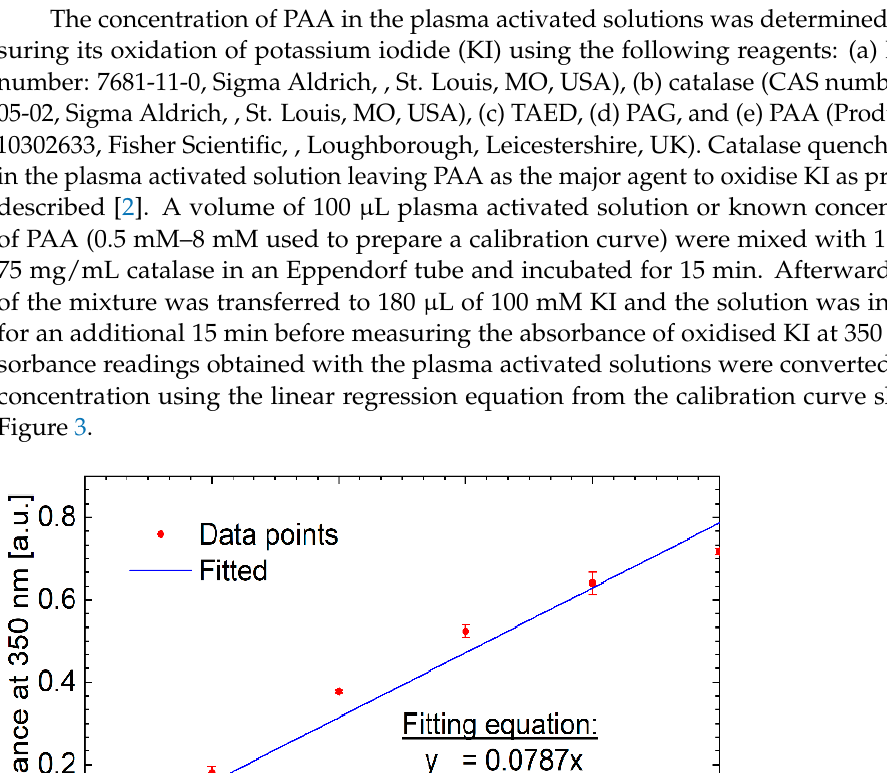
Figure 2. Calibration curve used for calculating the H 2 O 2 concentration in the plasma activated solutions using the linear regression equation shown in the graph.